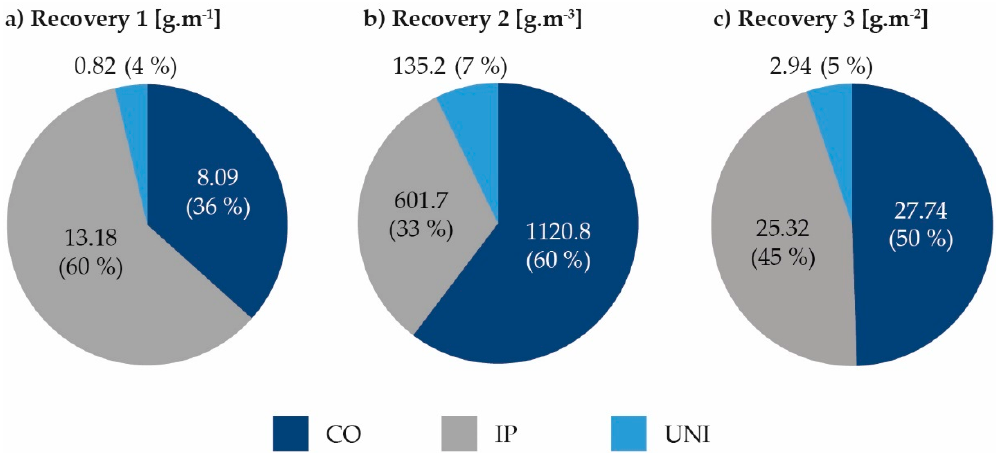
Figure 2. Effectiveness of methods depending on the chosen evaluation procedure per ( a ) unit length, ( b ) unit volume and ( c ) unit area of the cleaned pipe: The percentage was calculated as the ratio of the amount of TSS removed by the selected method to the total amount of TSS removed by three methods (IP − Ice Pigging ® ; UNI − Unidirectional flushing; CO − Comprex ® ).